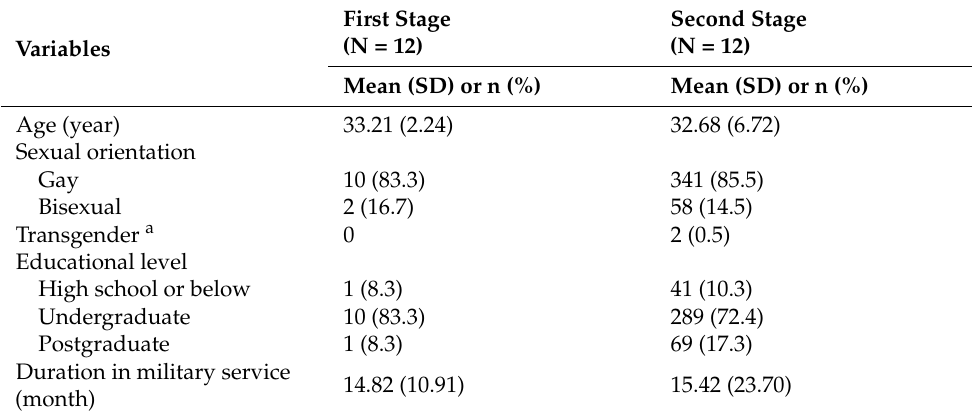
Table 1. Participants’